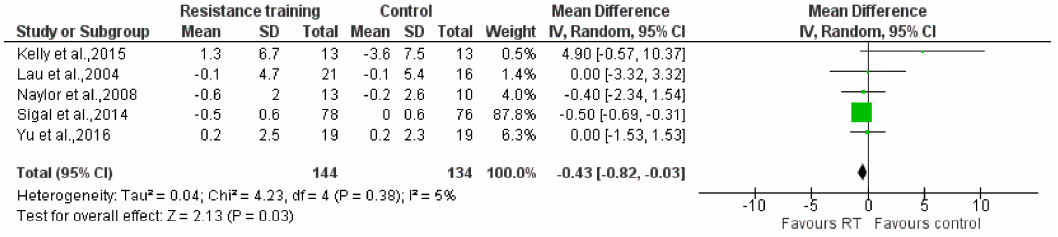
Figure 5. The effect of Resistance Training on body mass index (kg/m 2 ). Total: total number of subjects; CI: confidence interval.